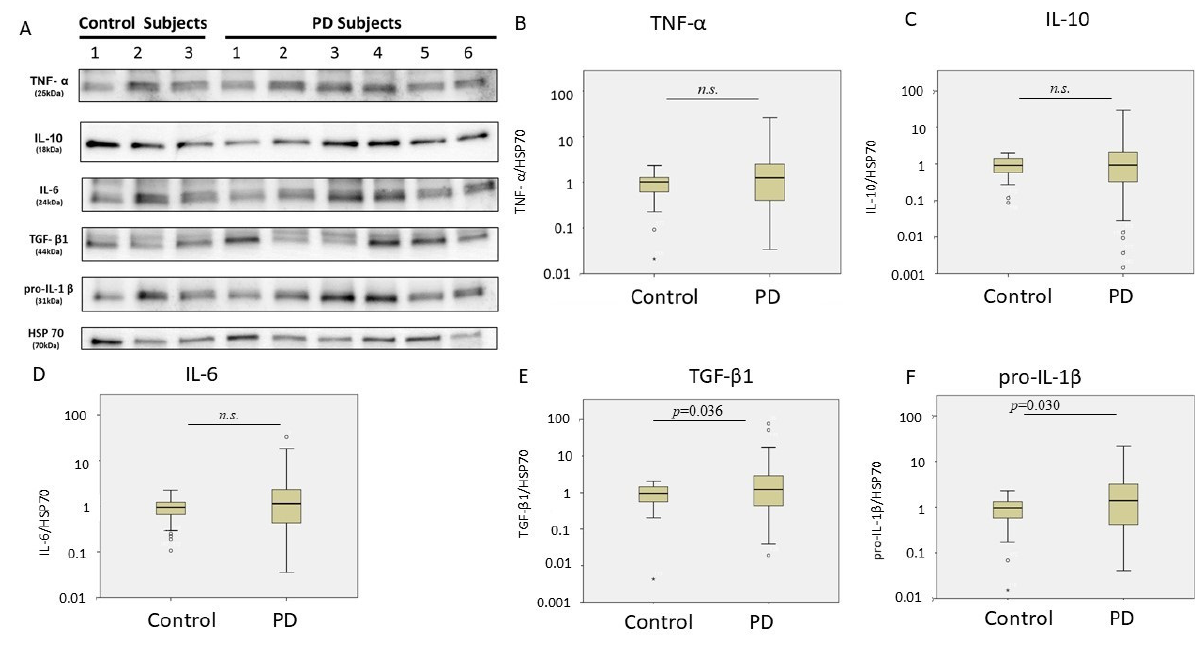
Figure 1. Cytokine levels in plasma extracellular vesicles in patients with Parkinson’s disease (PD) ( n = 113) and controls ( n = 48). ( A ) Representative protein blot images of different cytokines, including pro-interleukin (IL)-1 β , IL-6, IL-10, tumor necrosis factor (TNF)- α , and transforming growth factor (TGF)- β 1. Heat shock protein (HSP)-70 was the protein